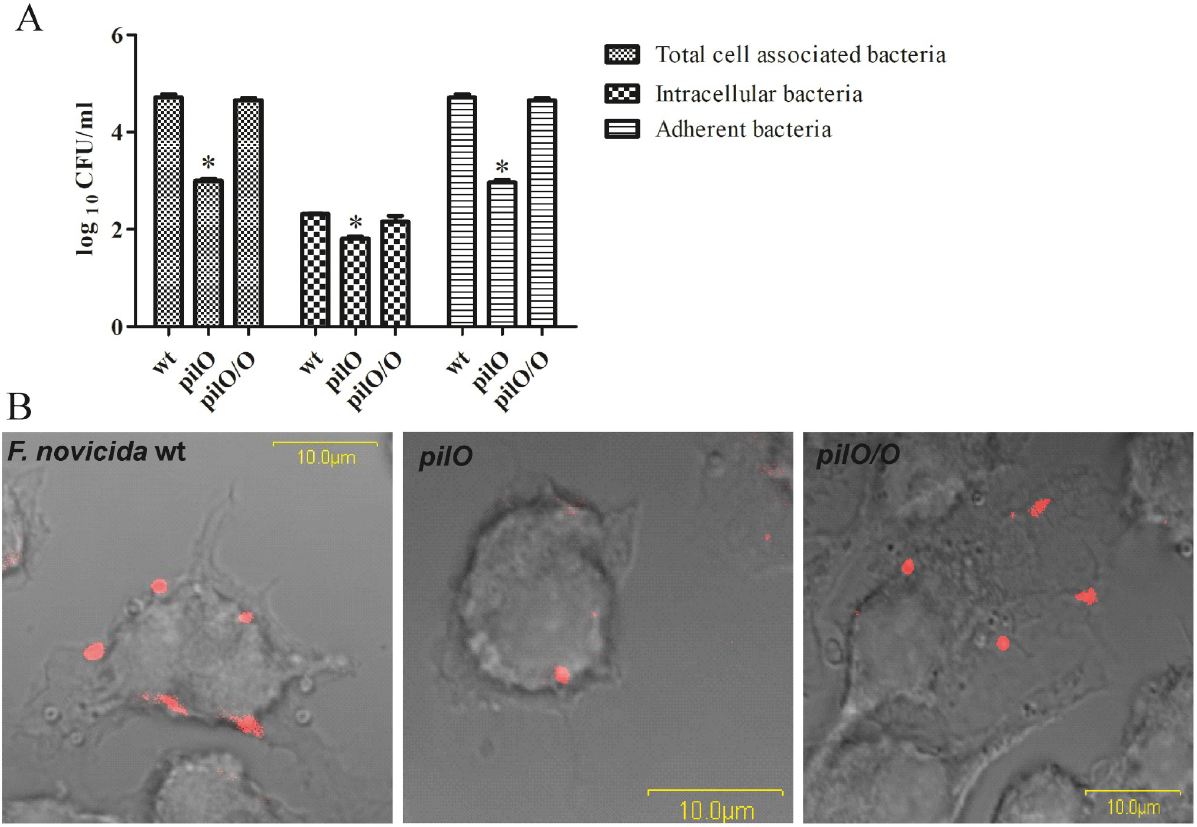
Fig 3. Adherence of the pilO mutant to HMDMs. Cells were infected with wt F . novicida , the pilO mutant and the complemented strain at MOI of 100 for 20 min. Unbound bacteria were removed by washing treatment. The number of adherent bacteria (A) was calculated by subtraction of the intracellular bacteria from the total number of cell associated bacteria. Confocal microscopy images (B) are demonstrating bacteria attached to the surface of HMDMs, where bacteria are labelled red. The images are representative based on analyzing 100 infected cells from three independent experiments. Asterisks denote that the adherence of the pilO mutant is statistically different from that of wt F . novicida , as determined by Student t- test ( � , p < 0.05).